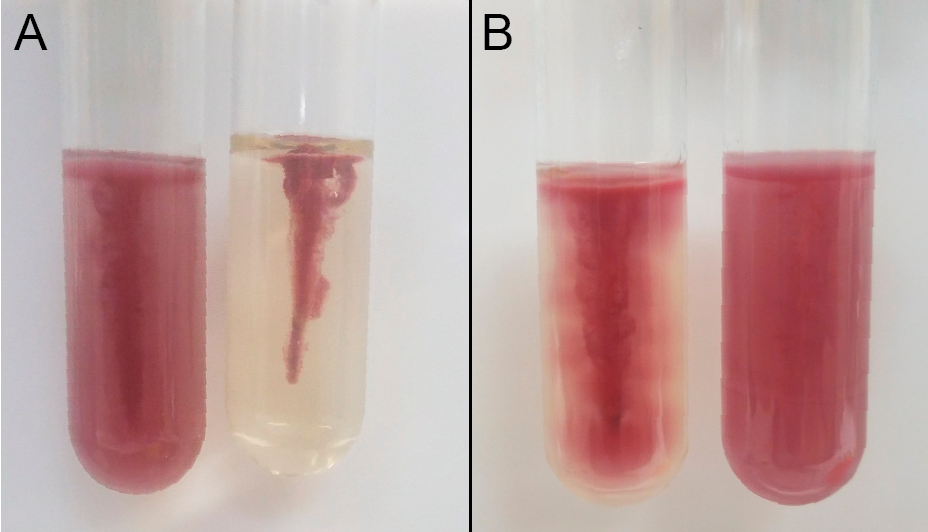
Figure 2. Triphenyltetrazolium Chloride (TTC) motility test media of ( A ) positive control Escherichia coli ATCC 25922 (left) and negative control Klebsiella pneumoniae ATCC 700603 (right) and ( B ) heat resistant isolates AW1.7 (left) and 128 (right). Results from TTC media of isolates 53, 63, and 111 were identical to isolate AW1.7 and isolate 8354 was identical to isolate 128.